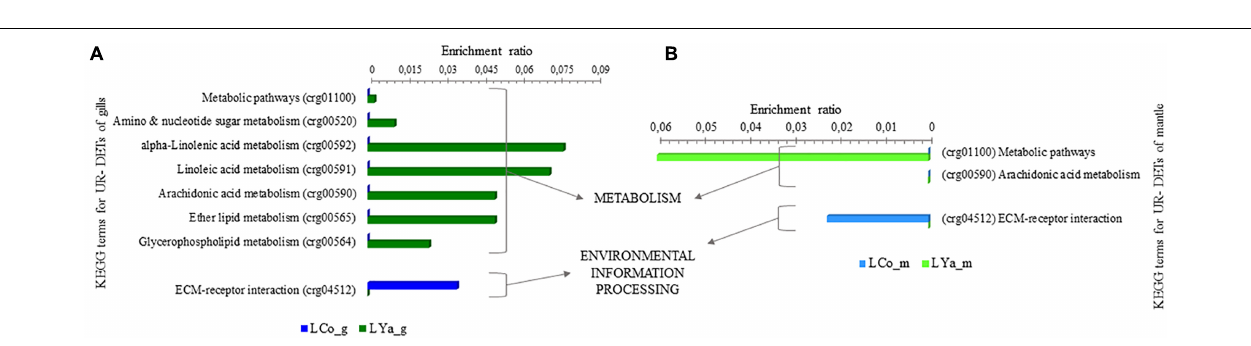
FIGURE 6 | KEGG categorization of differentially expressed transcripts (DETs) for intra-location by tissue comparison. The KEGG terms represented by up-regulated (UR-) DETs from Cochamó are in (A) and those represented by samples from UR-DETs from Yaldad in (B) . LCo, local individuals from Cochamó and LYa, locals from Yaldad. _m, mantle samples and _g, gill samples.